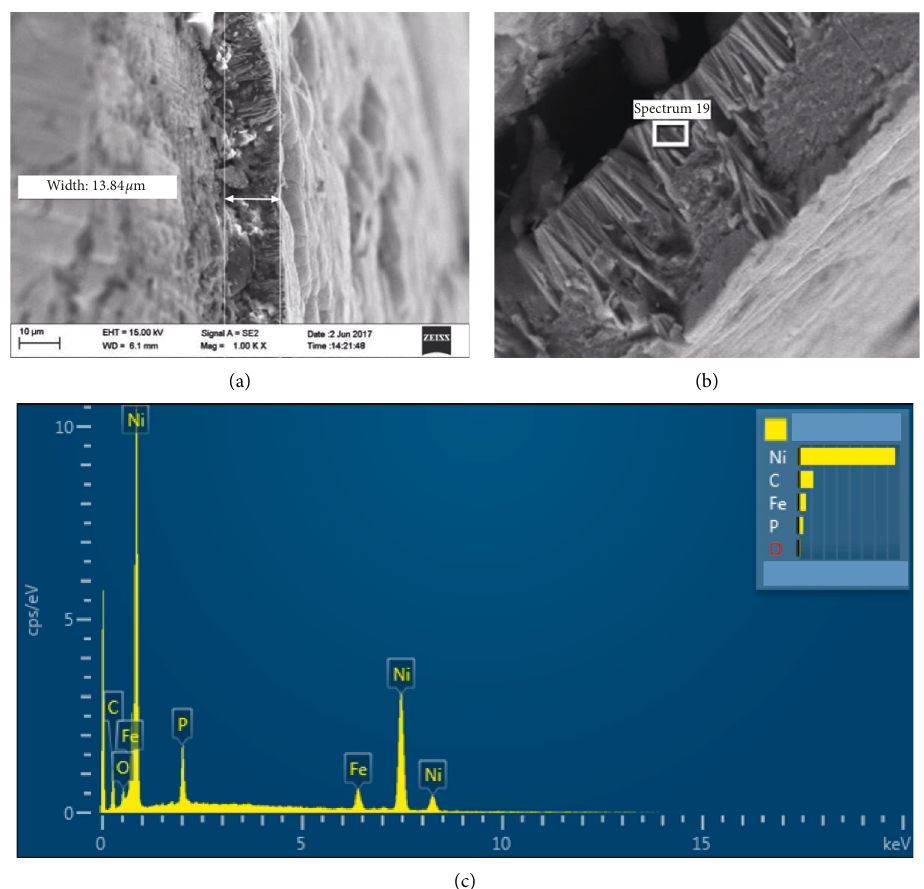
Figure 4: SEM image of the copper tool with nickel coating. (a) Thickness image of the composite tool. (b) Local image of the composite tool. (c) Local energy spectrum analysis of the copper